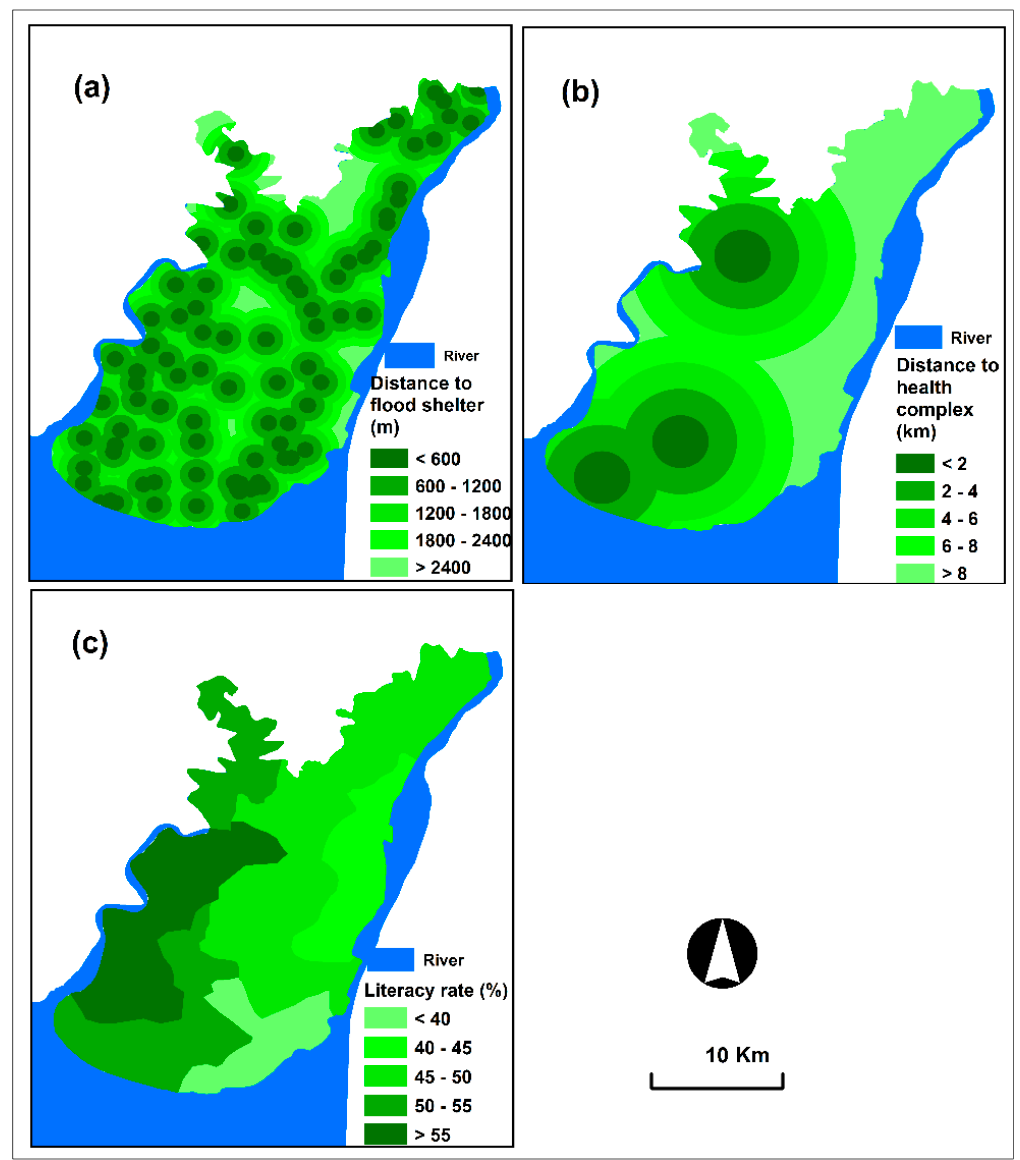
Figure 5. Coping capacity criterion layers: ( a ) distance to flood shelter, ( b ) distance to health complex and ( c ) literacy rate.